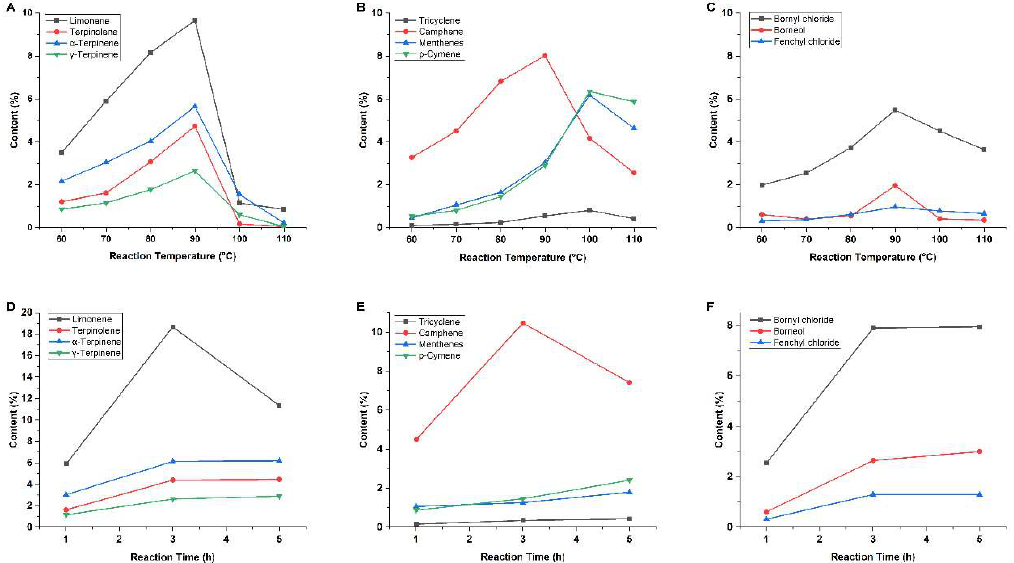
Figure 2. Effect of reaction temperature and reaction time on the yields of ( A , D ) p -menthadiene isomers, ( B , E ) other monomeric hydrocarbons, and ( C , F ) heteroatom-containing monomeric products. The reaction was carried out ( A – C ) for 1 h and ( D – F ) at 70 ° C.